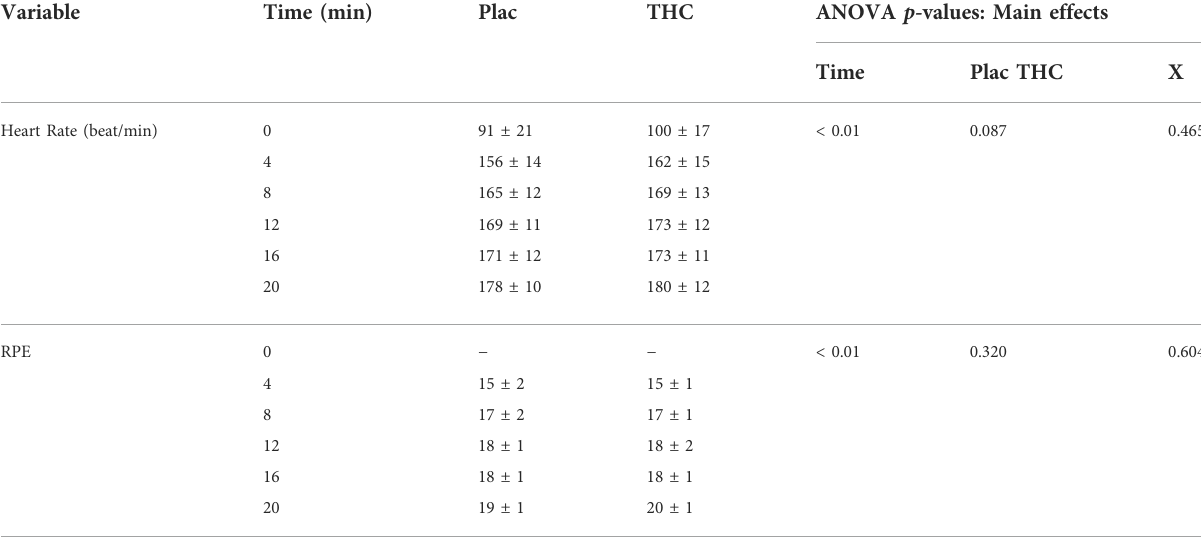
TABLE 3 Heart rate and ratings of perceived exertion during performance of the 20-min functional threshold power test (FTP 20 ) after ingestion of edible marijuana or placebo. Variable